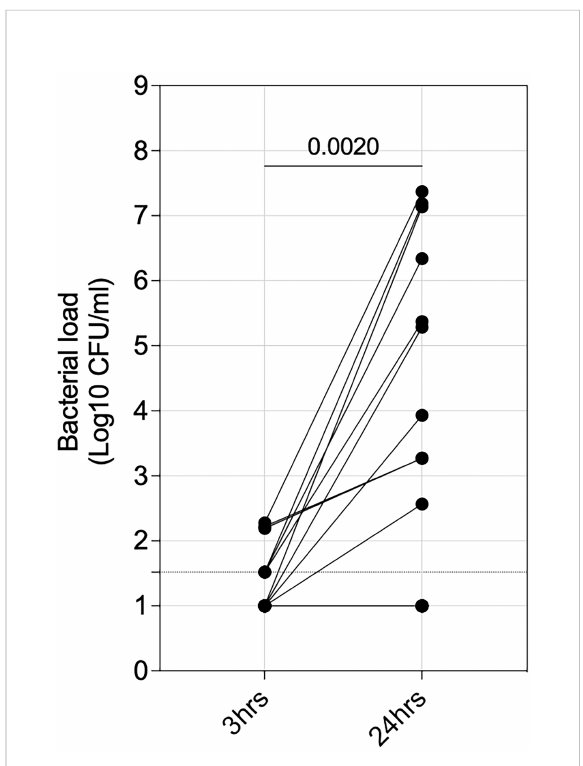
FIGURE 5 Propagation of extracellular pneumococci. Alveolar macrophages (AMs) were co-incubated with IgG-opsonised viable ST3 at MOI 50 for 1 hour, gentamicin was added for 30 minutes, then the cell culture supernatant was removed, replaced with gentamicin-free cell culture media and cells incubated. The graph shows outgrowth of pneumococci in cell culture supernatant at 3- and 24 hours (n=17). Statistics were calculated using Wilcoxon signed rank